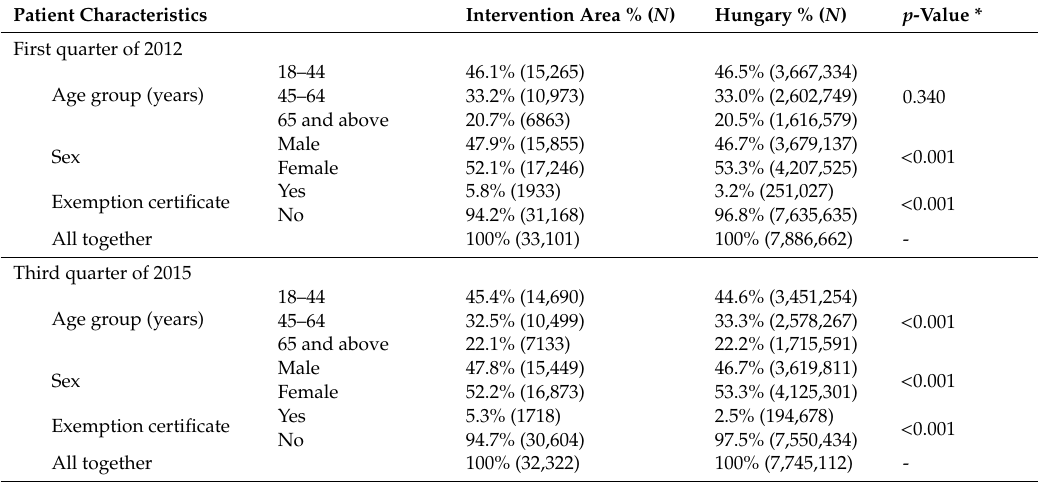
Table 1. Demographic composition of the population in the intervention area and